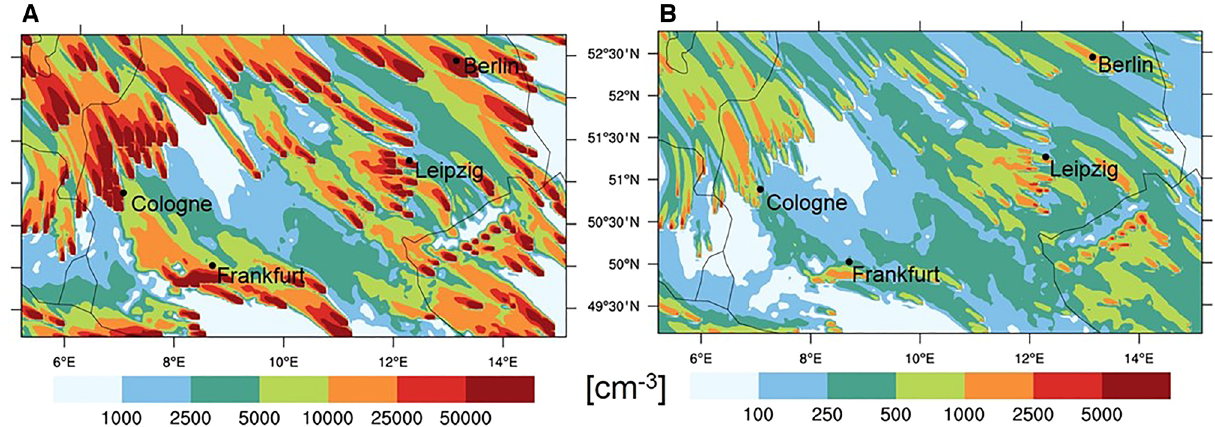
Figure 4. Comparison of primary Aitken mode particle plumes from power stations over northern Germany according to the German weather forecast model COSMO Art based on measured emissions ( A ) and on Y2000 (AeroCom, https:// aeroc om. met. no) based emissions ( B ) for southeasterly winds. The model was run for November conditions to suppress secondary gas to particle conversion (adapted from 14